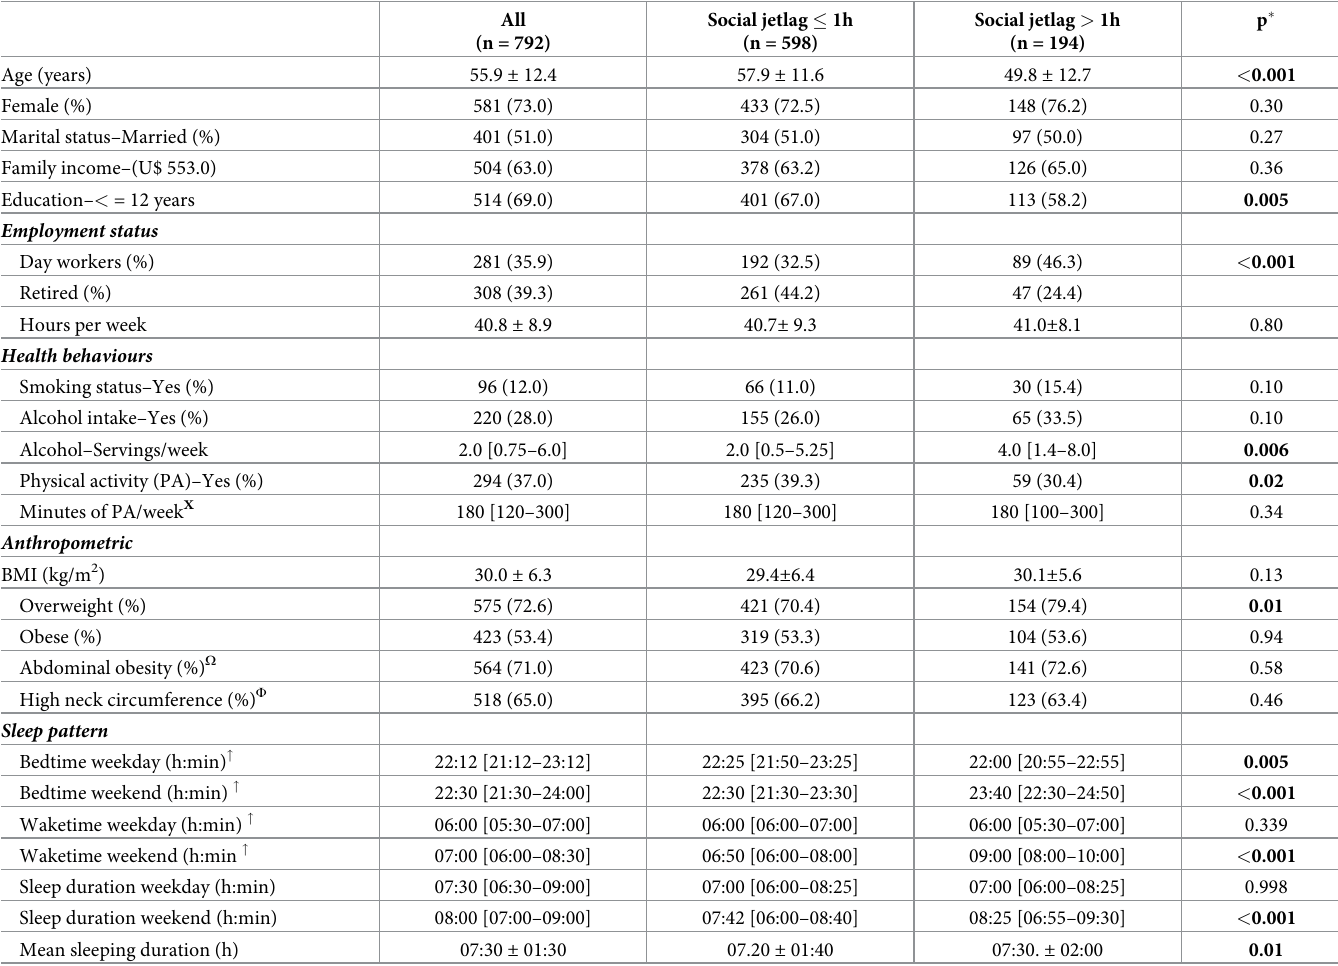
Table 1. Demographics, employment status, health behaviors, anthropometric variables and sleep pattern according to absence of social jetlag ( � 1h) or presence ( > 1h) (n =